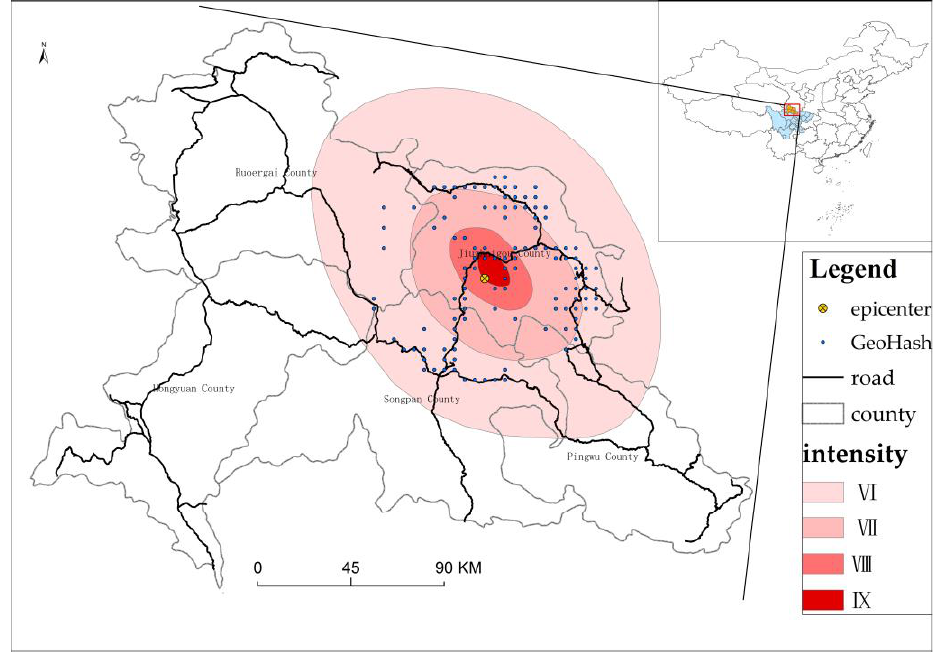
Figure 1. Location map of the study area.